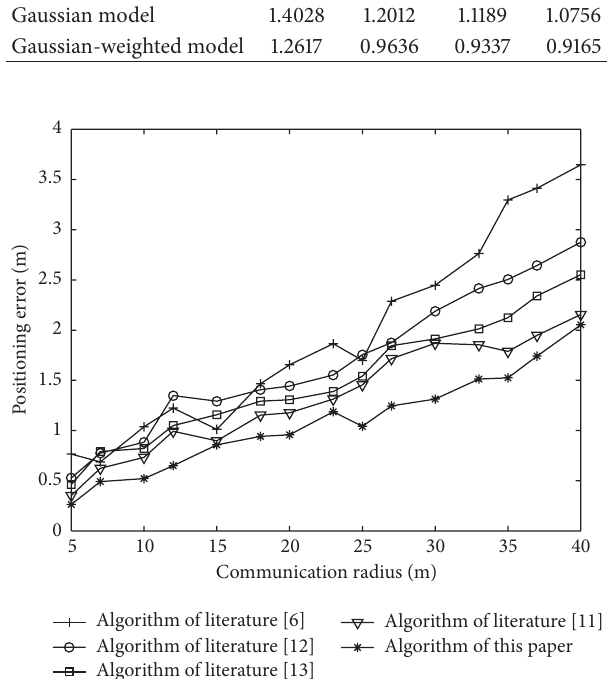
Figure 5: Comparison of the positioning error among different